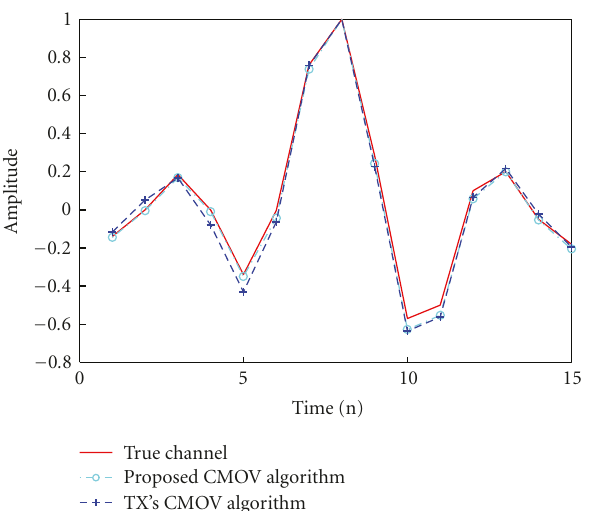
Figure 2: The channel estimation for colored input.